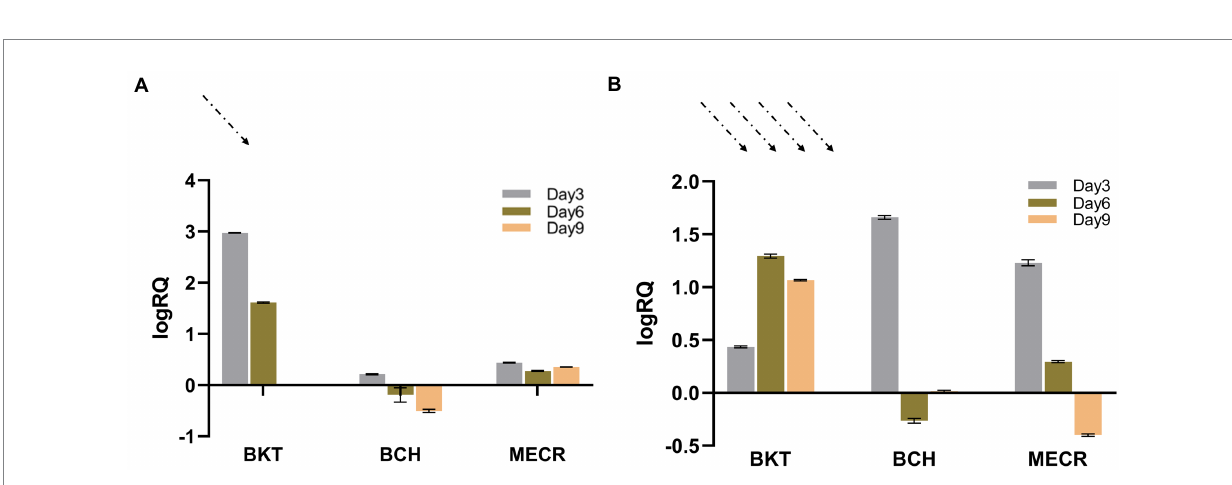
FIGURE 2 Results of real-time quantitative PCR. Dotted arrows indicate the intensity of light. (A) Results of 50 μ mol·m − 2 ·s − 1 light intensity, logRQ>0 indicates that the gene expression is up regulated compared with that on day 0. logRQ<0 indicates that the gene expression is down regulated. (B) Results of 195 μ mol·m − 2 ·s − 1 light